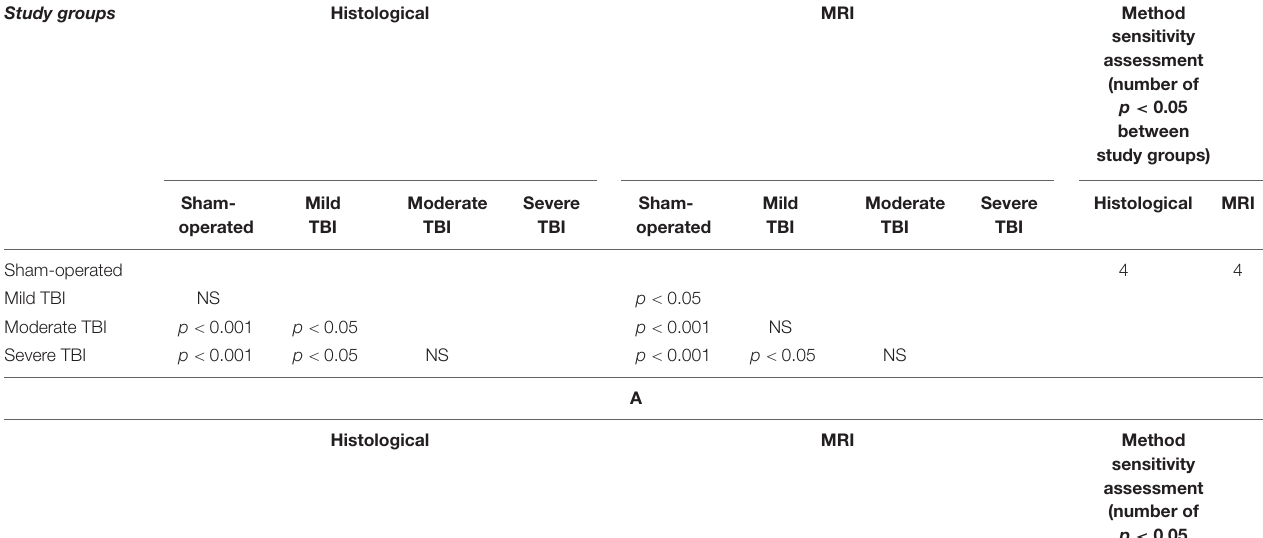
TABLE 2 | Comparison of significant differences (displayed as the p value) between the different experimental groups for (A) lesion volume, (B) brain edema, or (C) blood-brain barrier (BBB) breakdown 48 h after TBI by either histological and MRI-determined techniques. Study